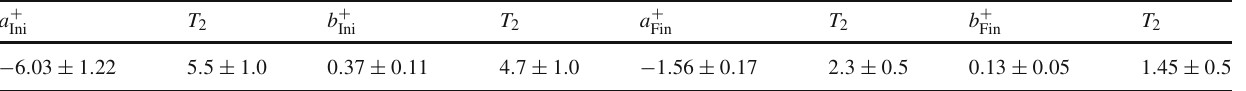
Table 1 Decay amplitudes a + J and b + J (in unit 10 − 3 GeV 2 ) and the corresponding Borel parameters (GeV 2 ) for the initial- and the final-state radiation